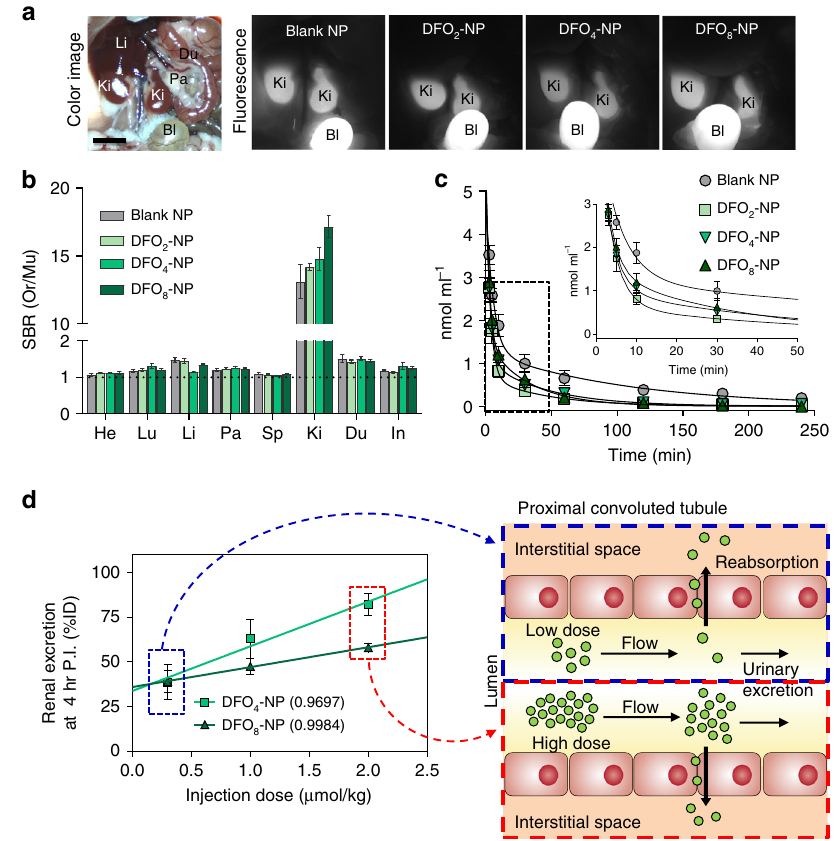
Fig. 2 Biodistribution and PK of DFO-NPs. a Color and NIR fl uorescence images of mouse abdominal cavity. DFO-NPs (0.3 µ mol kg − 1 ) were IV injected into CD-1 mice 4 h prior to imaging. Bl bladder, Du duodenum, Ki kidney, Li liver, Pa pancreas. Scale bar = 1 cm. b Biodistribution of DFO-NPs in major organs resected 4 h post-injection. He heart, In intestine, Lu lung, Mu muscle. The SBR was calculated by the fl uorescence intensity of each organ (Or) against Mu ( n = 5 per group, mean ± SEM). c Plasma concentration of DFO-NPs. The concentration (nmol ml − 1 ) of DFO-NPs in plasma at each time point was calculated from fl uorescence signal intensities. ( n = 5 – 8 per group, mean ± SEM). d Dose effect on renal clearance ef fi ciency of DFO 4 -NP and DFO 8 -NP ranging from 0.3 to 2 µ mol kg − 1 ( n = 3 per group, mean ± SEM) (left), and schematic drawing of dose-dependent elimination process at low (right, top) and high doses (right, bottom) Table 2 Pharmacokinetic parameters of DFO-NPs (0.3 µ mol kg − 1 ) Pharmacokinetic